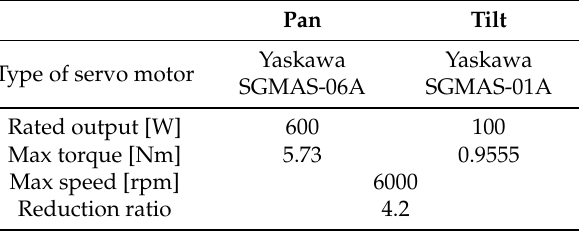
Table 3. Specifications in two axial